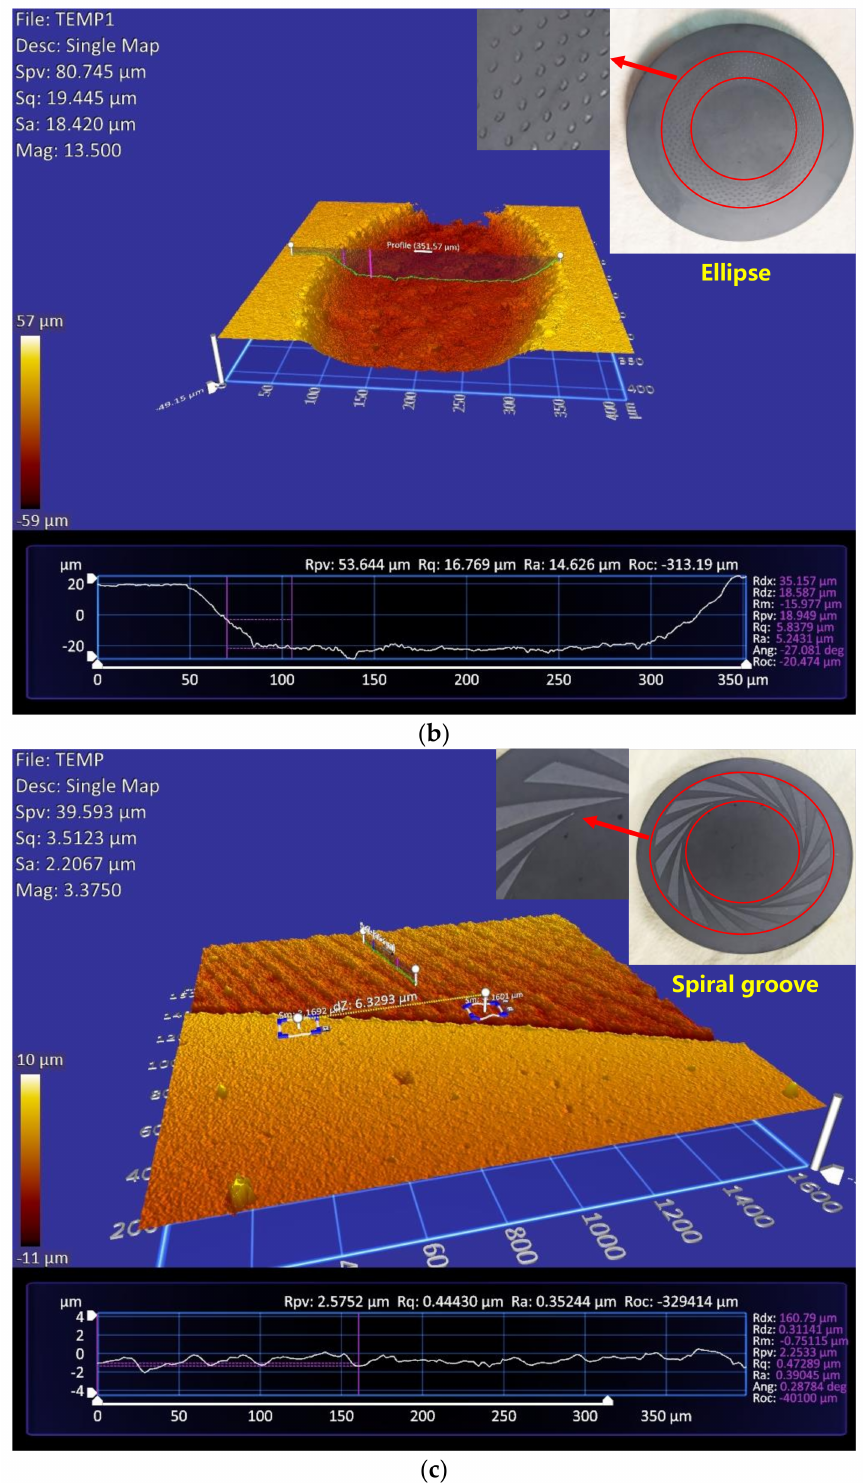
Figure 2. Morphologies of triangle ( a ), ellipse ( b ) and conventional spiral groove ( c ) texture